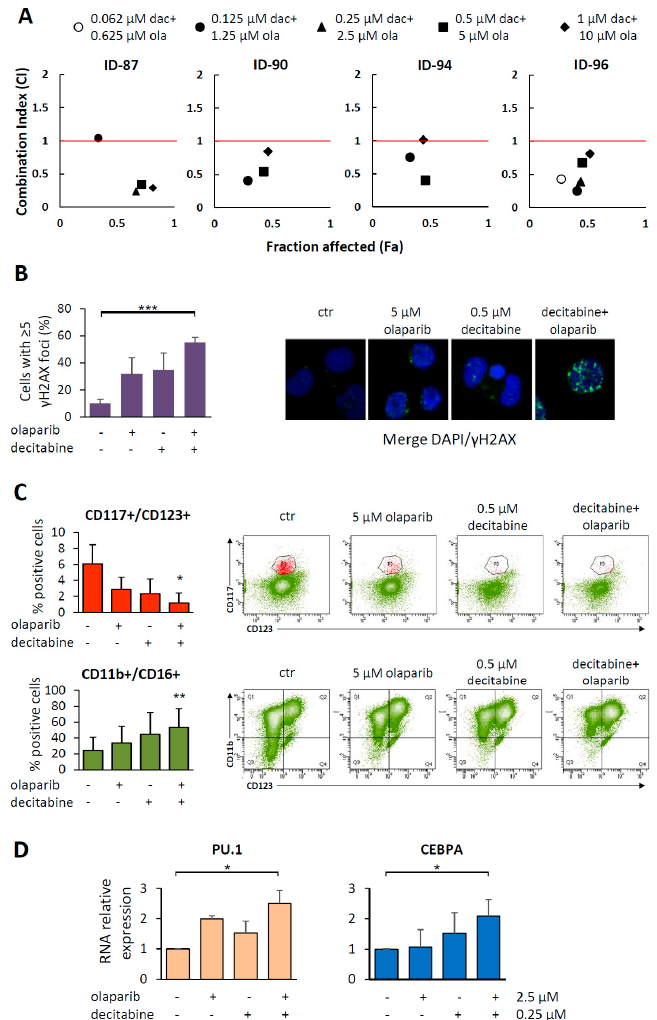
Figure 6. The olaparib and decitabine combination impairs survival and induces differentiation in primary MDS. ( A ) Primary MDS cells were treated with olaparib (ola, 0–10 µM) or decitabine (dac, 0–1 µM) or with different drug combinations at time 0. After 7 days of culture, cells were analyzed by the MTS assay to study cytotoxicity. Plots show the fraction of affected cells (Fa, x axis) and the combination index (CI, y axis) values as assessed by the CompuSyn model. Each plot indicates the CI values of a MDS samples treated at decitabine and olaparib 1:10 ratio. CI < 1, synergistic activity; CI = 1, additive effect; CI > 1, antagonism. ( B ) Analysis of γ H2AX foci by immunofluorescence after 72 h of exposure of ID-90 cells to 5 µM olaparib and 0.5 µM decitabine, as single agents or in combination. Values are the mean percentage ±SD of the cells with ≥ 5 γ H2AX foci in four quadrants, containing at least 50 cells each. Statistical analysis was performed by Kruskal-Wallis followed by Dunn’s test. Representative nuclei of untreated or drug-treated MDS cells are shown. Cells were probed with γ H2AX (green stain) and DAPI (blue). Images were taken at 40× magnification. ( C ) Histograms show the mean percentage ± SD of CD117+/CD123+ and CD11b+/CD16+ cells in 3 MDS samples untreated or treated with 5 µ M olaparib and 0.5 µ M decitabine, as single agents or in combination. Statistical analysis by Friedman followed by Dunn’s test: * p < 0.05, ** p < 0.01. Representative dot plots showing data from a MDS sample (ID-88) untreated or treated with olaparib, decitabine or both drugs. A decrease of CD117 +/ CD123 + immature progenitors (upper plots) and increase of CD11b +/ CD16 + (lower plots) are observed in treated samples as compared to the untreated control. ( D ) PU.1 and CEBPA mRNA expression evaluated by qRT-PCR after 7 days of treatment with olaparib and decitabine, as single agents or in combination. Histograms show the mean ± SD relative expression in three MDS samples. Statistical analysis by Kruskal-Wallis followed by Dunn’s test: * p < 0.05, ** p < 0.01, *** p <